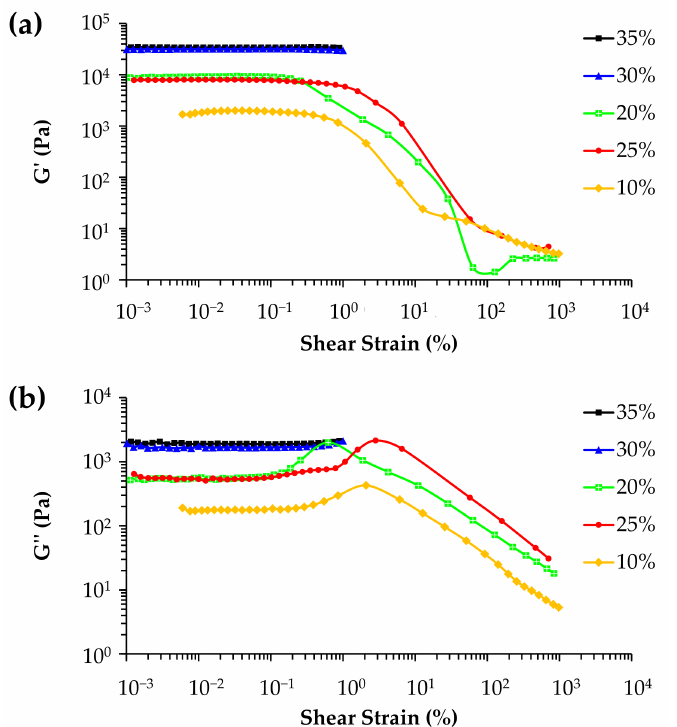
Figure 3. Shear strain dependence of the viscoelastic parameters: ( a ) elastic modulus, G (cid:48) , and ( b ) storage modulus G (cid:48)(cid:48) on solid